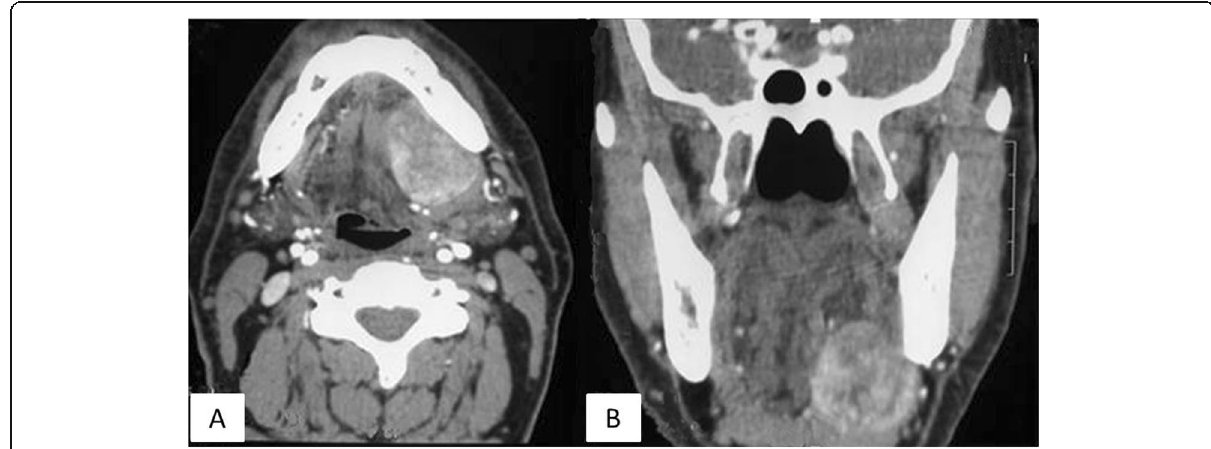
Fig. 1 Post-contrast-computed tomography image. A Axial view. B Coronal view, showing an enhancing submandibular mass lesion in the left side